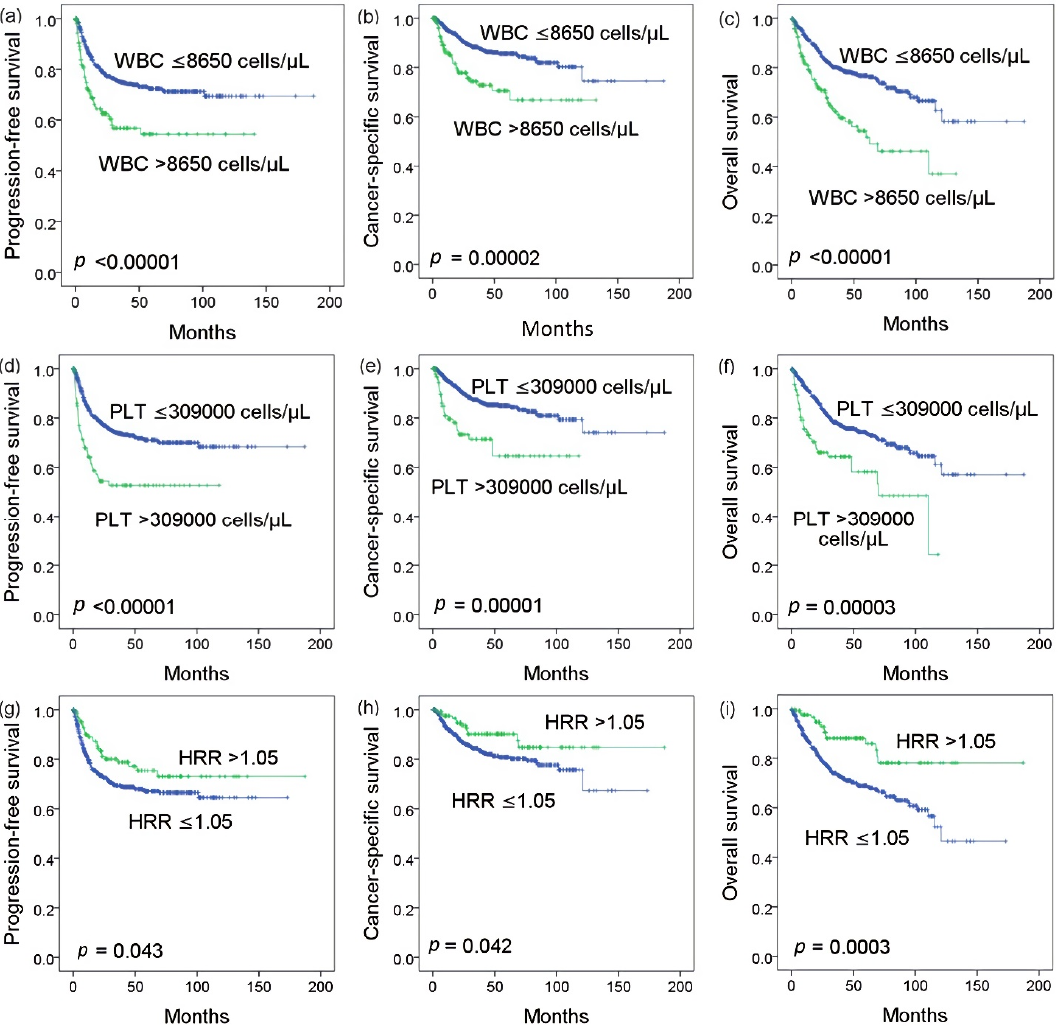
Figure 1. Kaplan–Meier analysis showing that progression-free survival, cancer-specific survival, and overall survival are significantly associated with white blood cell (WBC) count ( a – c ), platelet (PLT) count ( d – f ), and hemoglobin-to-red cell distribution width ratio (HRR) level ( g – i ).